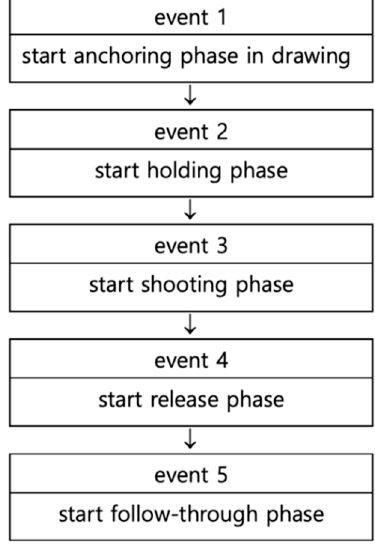
Figure 3. Events flow chart.